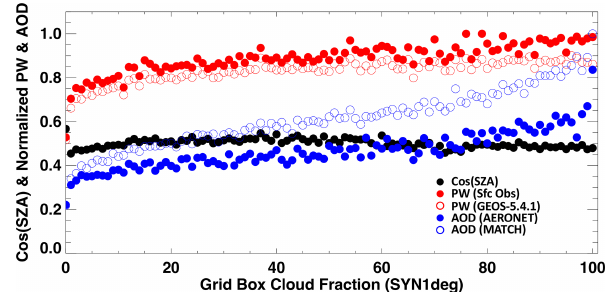
Figure 10. AOD and precipitable water (PW) as a function of cloud fraction over the 1 ◦ × 1 ◦ grid box where the ARM SGP E13 and SURFRAD (SURFace RADiation program) Bondville, IL, sites are located. Closed and open blue circles are AOD derived from AERONET and MATCH AOD, respectively. Closed red circles are observed PW from either a microwave radiometer or CIMEL sun photometer, and open red circles are PW from the GEOS-5.4.1 re- analysis. Cloud fractions are derived from MODIS and geostation- ary satellites. Black dots are the mean cosine solar zenith angle of the time of AOD and PW observations. AOD and PW are normal- ized to their maximum value for display.